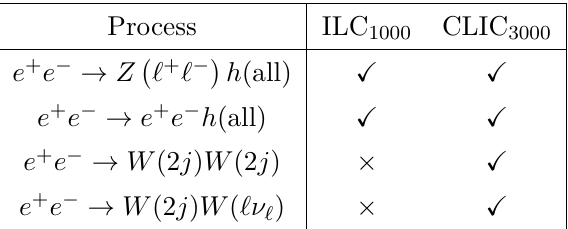
Table 1. List of processes included in the high-energy fit performed in this work for ILC 1000 and CLIC 3000